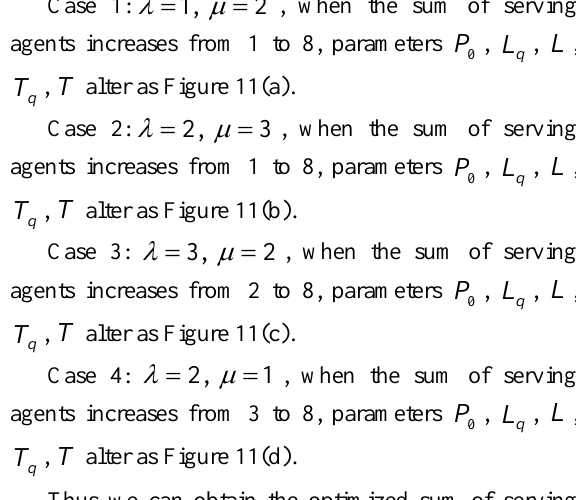
Fig.12. Multi-agent interactions relationship.